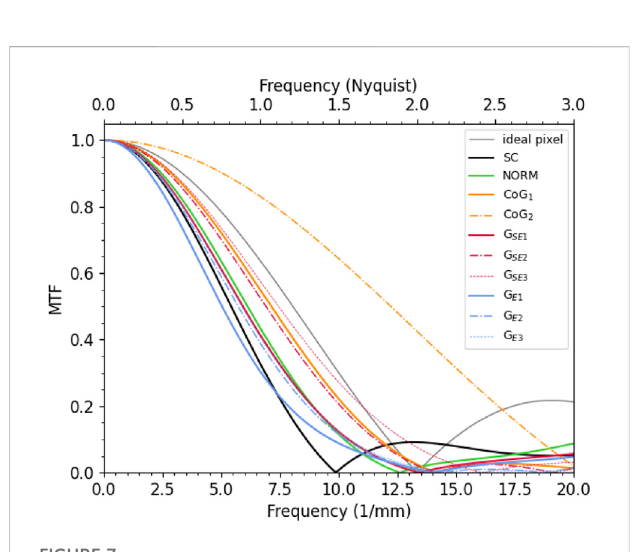
FIGURE 8 NNPS for the different probed processing methods. For normalization purposes, the NNPS was multiplied by the scalar Q. The frequency range is